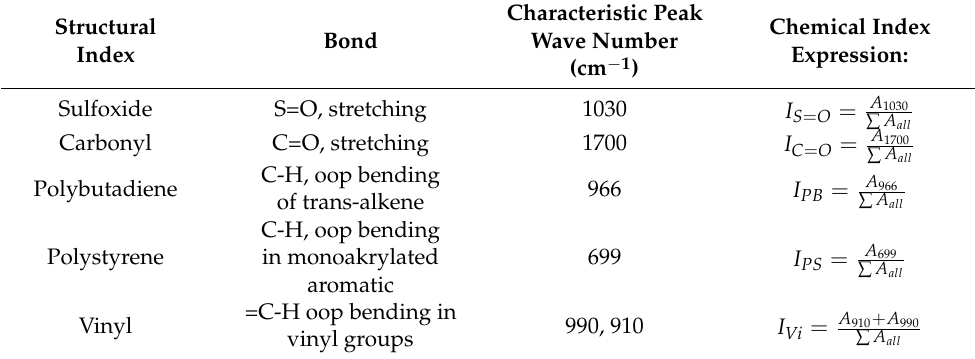
Table 4. Structural indices calculated for the bituminous binders